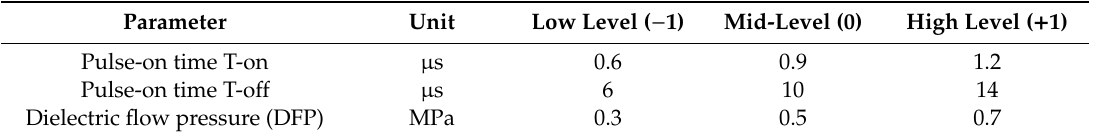
Table 1. Variable machining parameters and their levels for the wire electrical discharge machining (WEDM) research of Inconel 617.